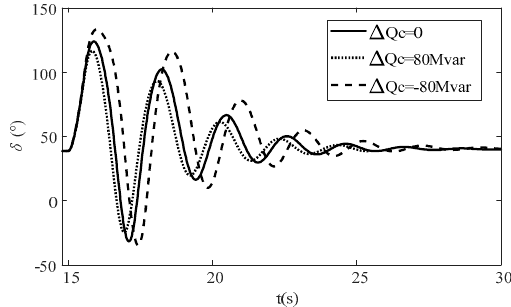
Figure 13. Comparison of control effects under reactive power variation at rectifier side.